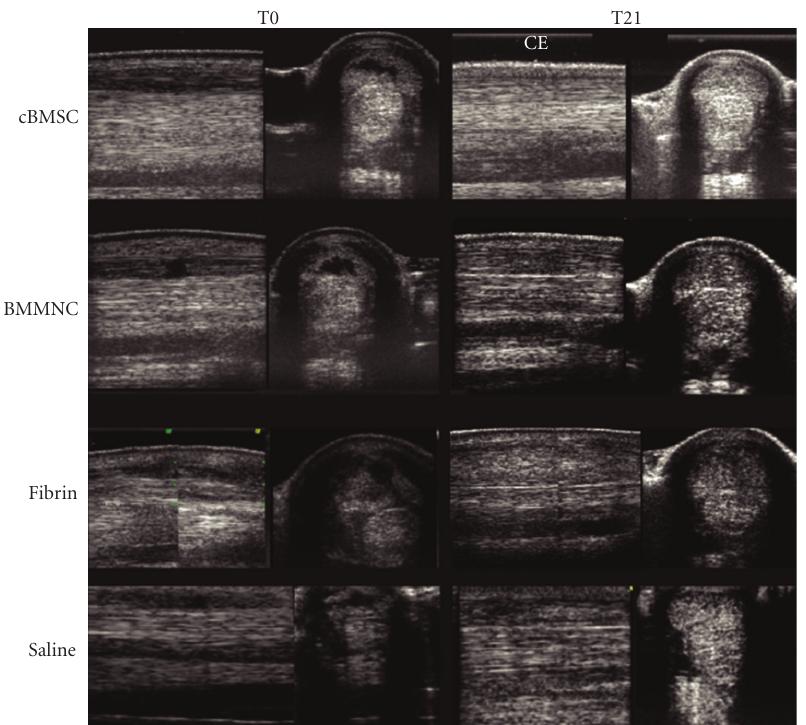
Figure 2: Longitudinal and transverse ultrasound images recorded on T0, that is, the day of injection of intralesional cultured bone marrow mesenchymal cells (cBMSC), bone marrow Mononucleated Cells (BMMNCS), fibrin and saline, and at T21, 21 weeks after